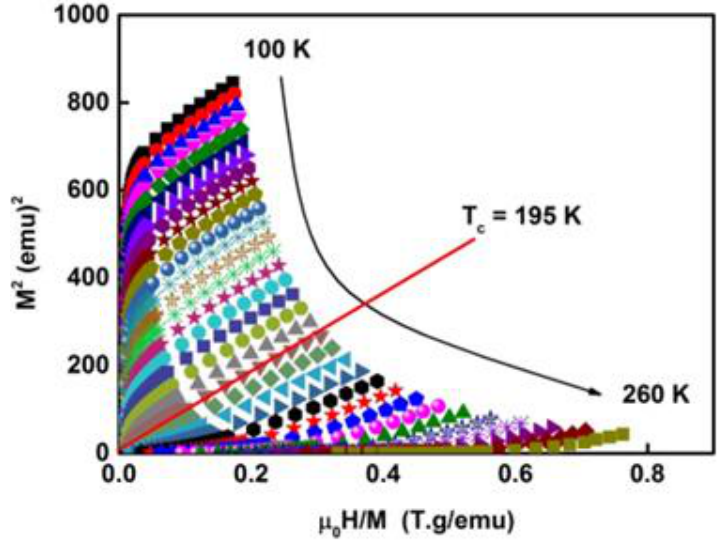
Figure 5. Standard Arrott plot isotherms 𝑀 2 𝑣𝑠. 𝜇 0 𝐻/𝑀 . From 100 to 260 K (increments of 5 K).